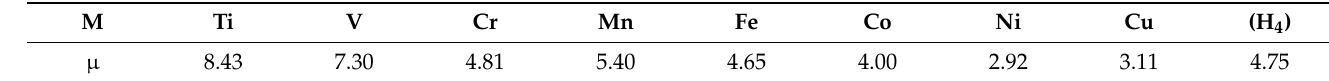
Table 2. Electric dipole moments ( µ , Debye) of M(N 12 ) compounds calculated by DFT M06/TZVP